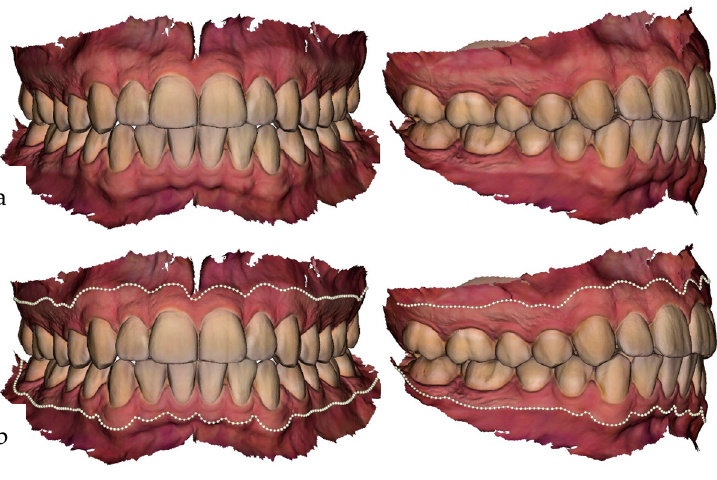
Figure 1. The MG-BL can be identified by the difference in color of attached gingiva and free mucosa. The MT-BL is clearly visible at the junction between tooth and gingiva ( a ). The MT-BL and MG-BL are placed in 3D Slicer using curves based on sliding semi-landmarks ( b ).